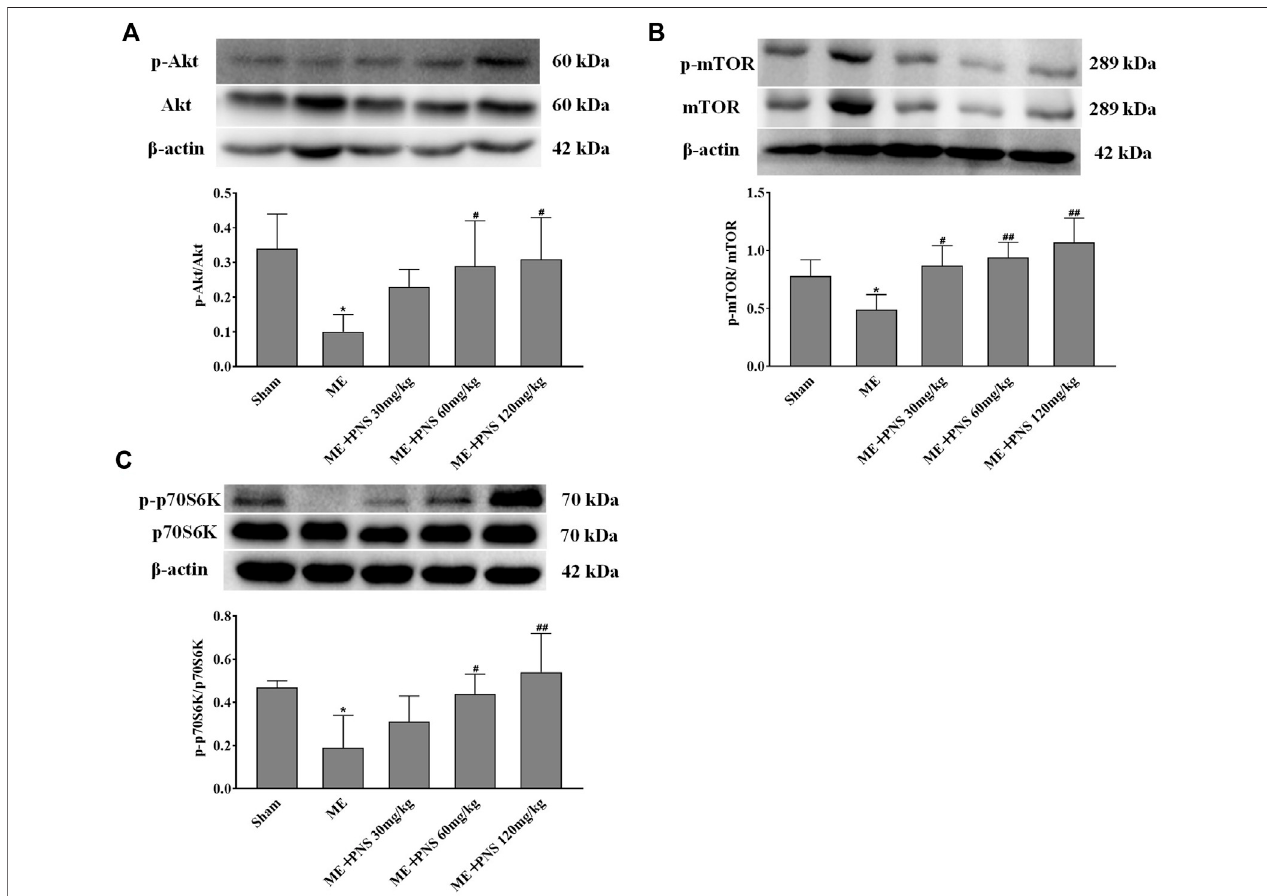
FIGURE 7 | PNS administration activated Akt/mTOR/p70S6K pathway in ME rats. ( A − C ) The protein levels of p-Akt, Akt, p-mTOR, mTOR, p-p70S6K, and p70S6K in hippocampus tissues were detected by Western blot. Data were shown as means ± standard deviation ( n = 3 animals per group). * p < 0.05, ** p < 0.01 verssus Sham group; # p < 0.05, ## p < 0.01 versus ME